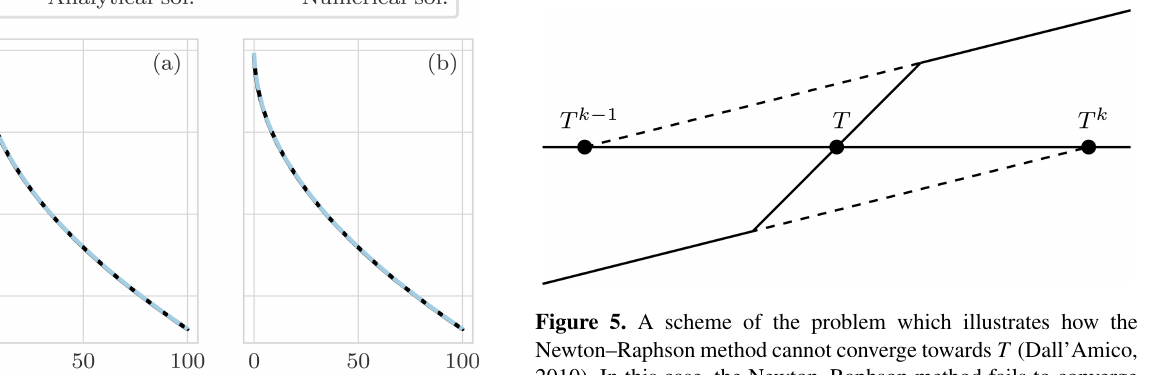
was 0 . 001 m, and the parameter (cid:15) was increased to − 0 . 01 ◦ C to match the analytical solution. The maximum absolute er- ror of the freezing front position was 0 . 00099 m.